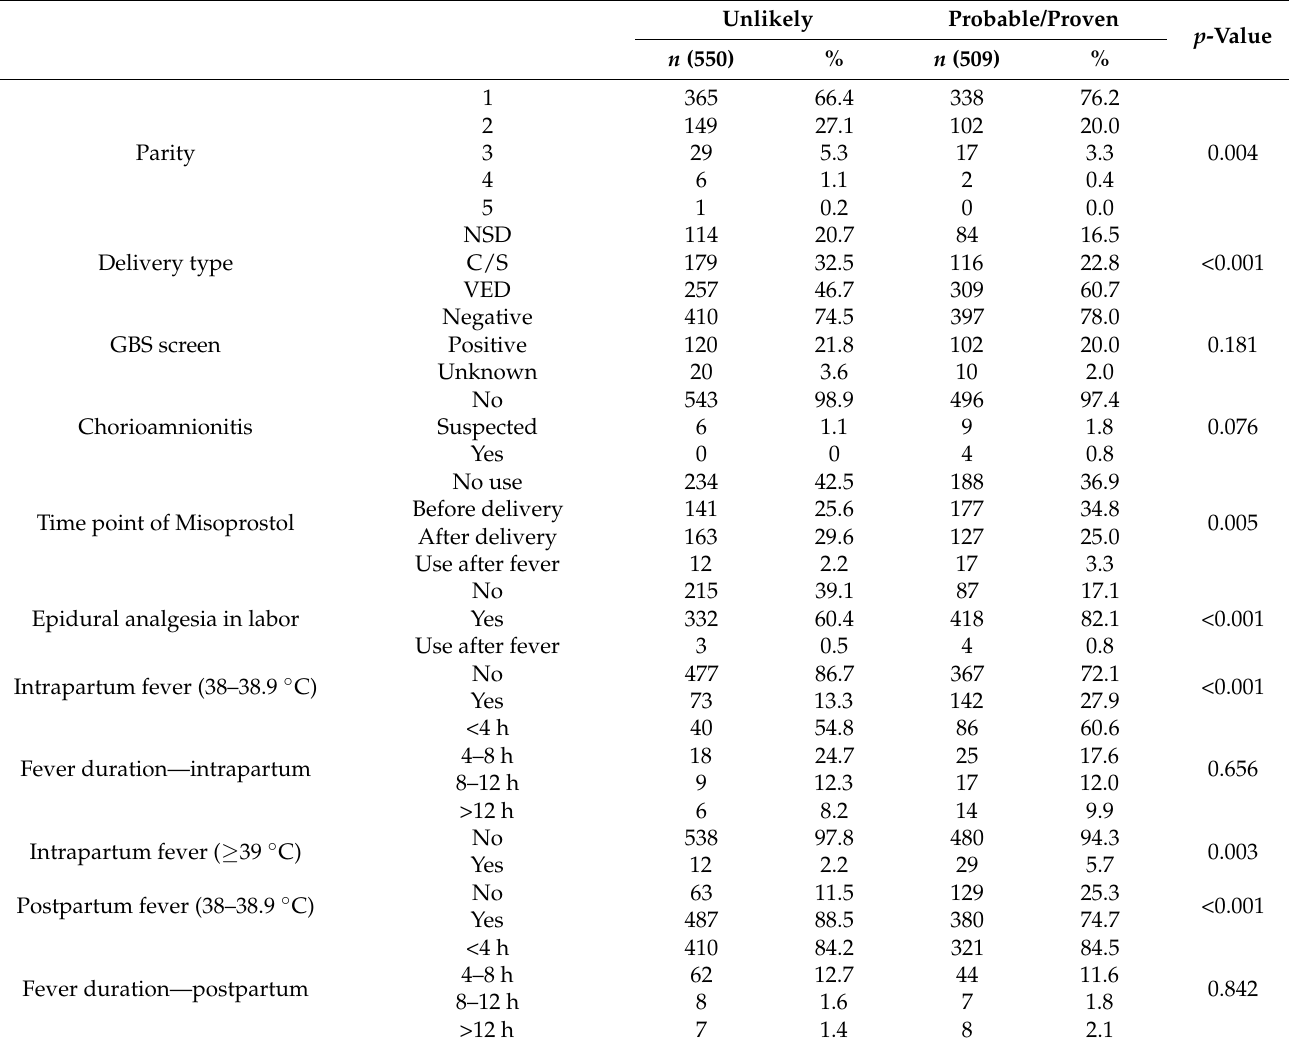
Table 3. Relationship between perinatal factors and neonatal sepsis. Unlikely